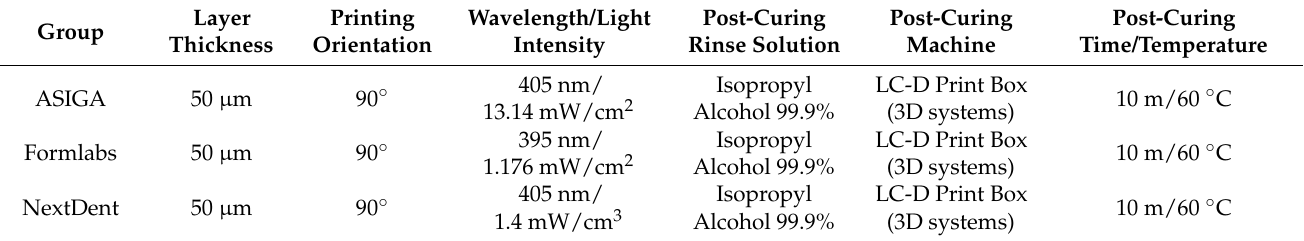
Table 2. Printing parameters used.